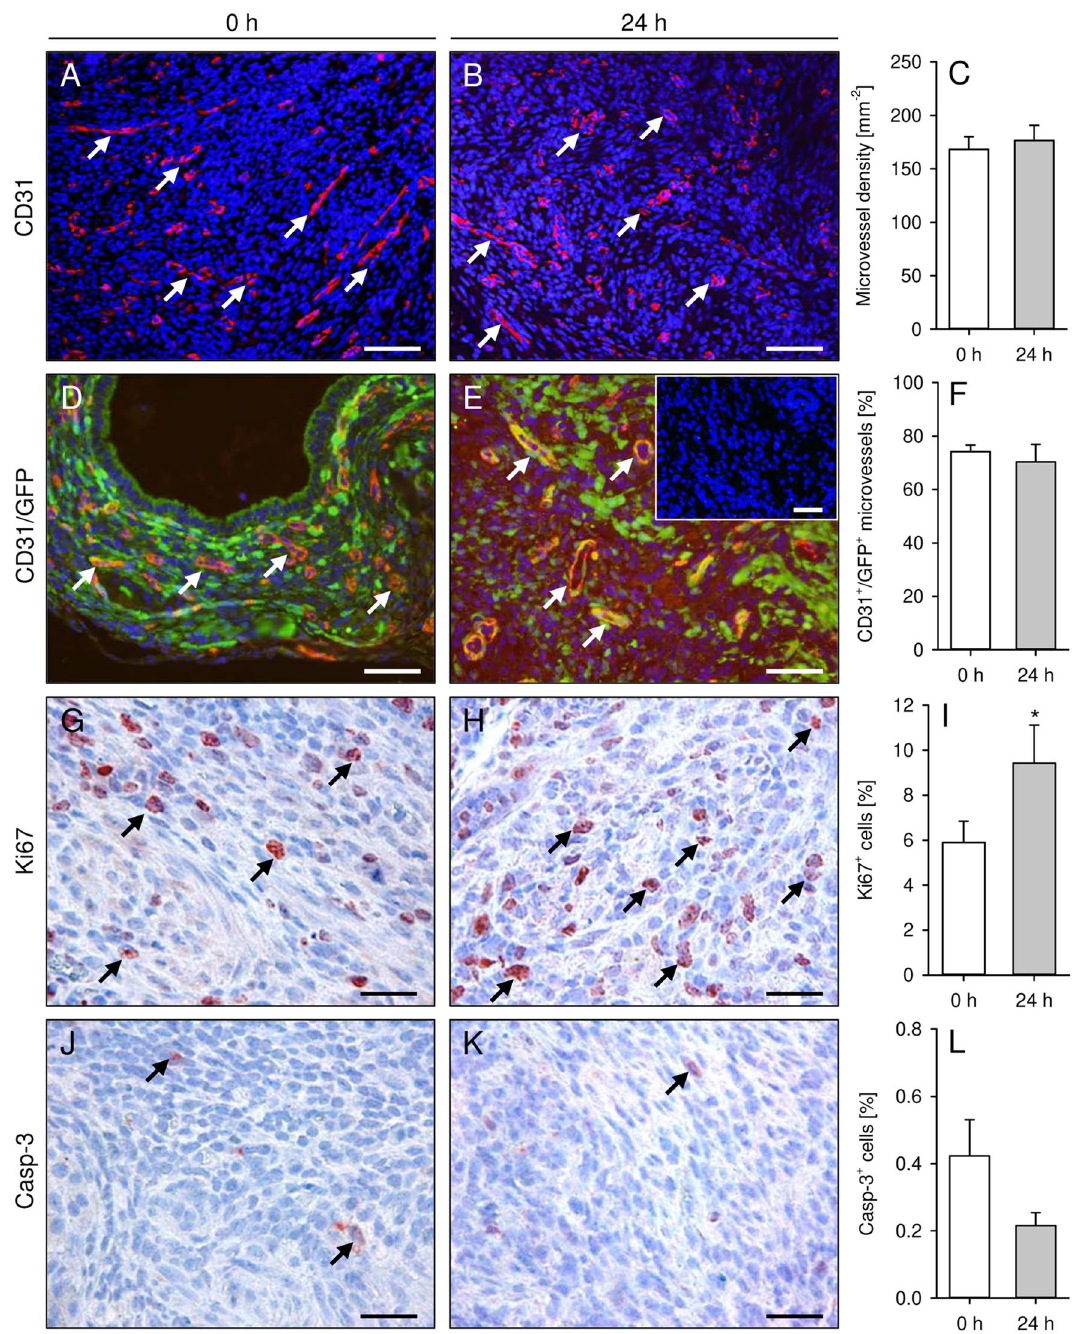
Figure 5. ( A , B , D , E ) Immunofluorescent detection of CD31 + microvessels ( A , B ; arrows) and CD31 + /GFP + microvessels ( D , E ; arrows) in endometriotic lesions on day 28 after transplantation of freshly isolated (0 h; A , D ) and 24-h-precultivated ( B , E ) uterine tissue samples from C57BL/6-TgN(ACTB-EGFP)1Osb/J donor mice to the peritoneal wall of C57BL/6J recipient mice. The immunofluorescent sections were stained with Hoechst 33342 to identify cell nuclei (blue), an antibody against CD31 for the detection of microvessels (red) and an antibody against GFP to detect GFP + microvessels (green; D , E ). Insert in E shows negative staining control. Scale bars: ( A , B ) = 60 µm; ( D , E ) insert = 40 µm. ( G , H , J , K ) Immunohistochemical detection of Ki67 + proliferating cells ( G , H ; arrows) and Casp-3 + apoptotic cells ( J , K ; arrows) in endometriotic lesions on day 28 after transplantation of freshly isolated (0 h; G , J ) and 24-h-precultivated ( H , K ) uterine tissue samples from C57BL/6-TgN(ACTB-EGFP)1Osb/J donor mice to the peritoneal wall of C57BL/6J recipient mice. To detect proliferating ( G , H ) and apoptotic cells ( J , K ), the sections were stained with an antibody against Ki67 and Casp-3. Scale bars: ( G , H , J , K ) = 25 µm. ( C , F , I , L ): Microvessel density ( C , mm −2 ), CD31 + /GFP + microvessels ( F , %), Ki67 + proliferating cells ( I , %) and Casp-3 + apoptotic cells ( L , %) in endometriotic lesions on day 28 after transplantation of freshly isolated (0 h; white bars; n = 10) and 24-h-precultivated (grey bars; n = 6) uterine tissue samples from C57BL/6-TgN(ACTB-EGFP)1Osb/J donor mice to the peritoneal wall of C57BL/6J recipient mice. Mean ± SEM; *P < 0.05 vs. 0